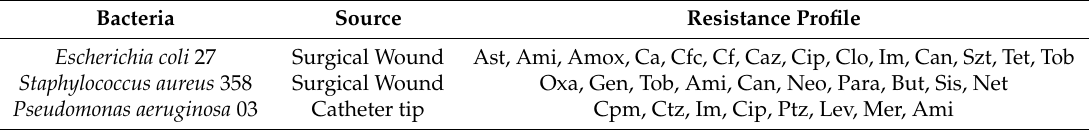
Table 2. Bacterial resistance profile against